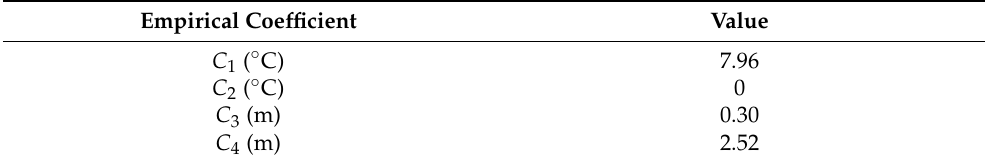
Table 1. Experimental coefficients estimated from solver optimization (Equations (2)–(4)) applied on the temperature profile measured ( T obs (z)) in 2015 at the INRS experimental site before a TRT. Empirical Coefficient Value